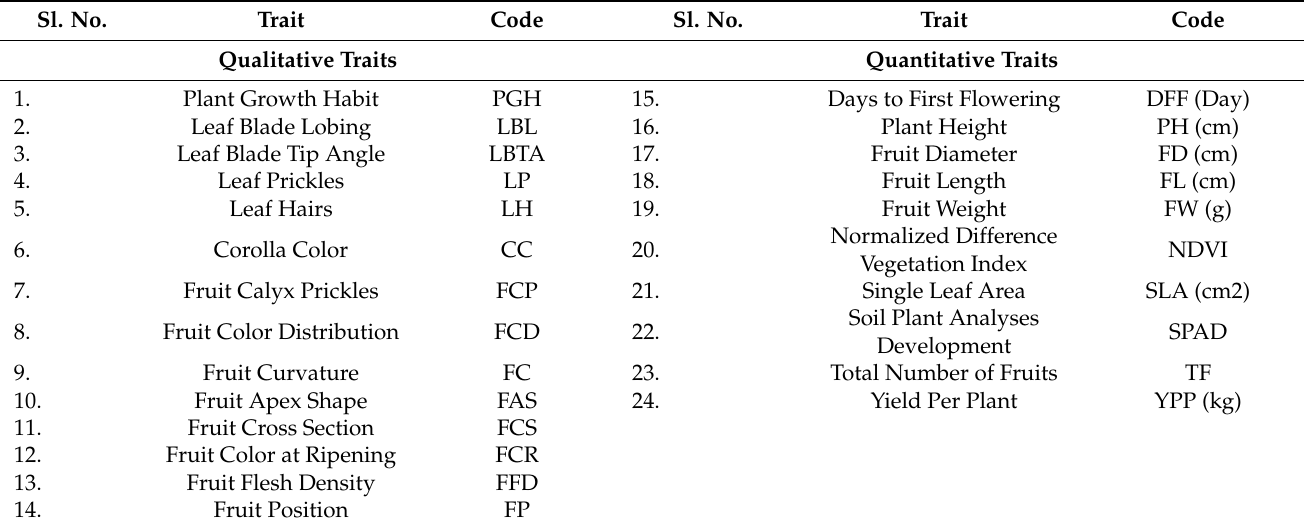
Table 1. Fourteen qualitative traits and ten quantitative